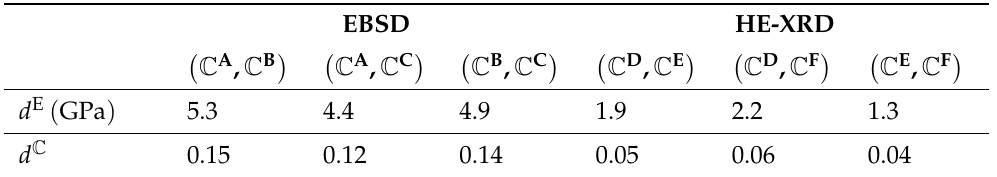
Table 4. Comparison of elasticity tensors from single specimens in case of EBSD ( C A , C B , C C ) and HE-XRD ( C D , C E , C F